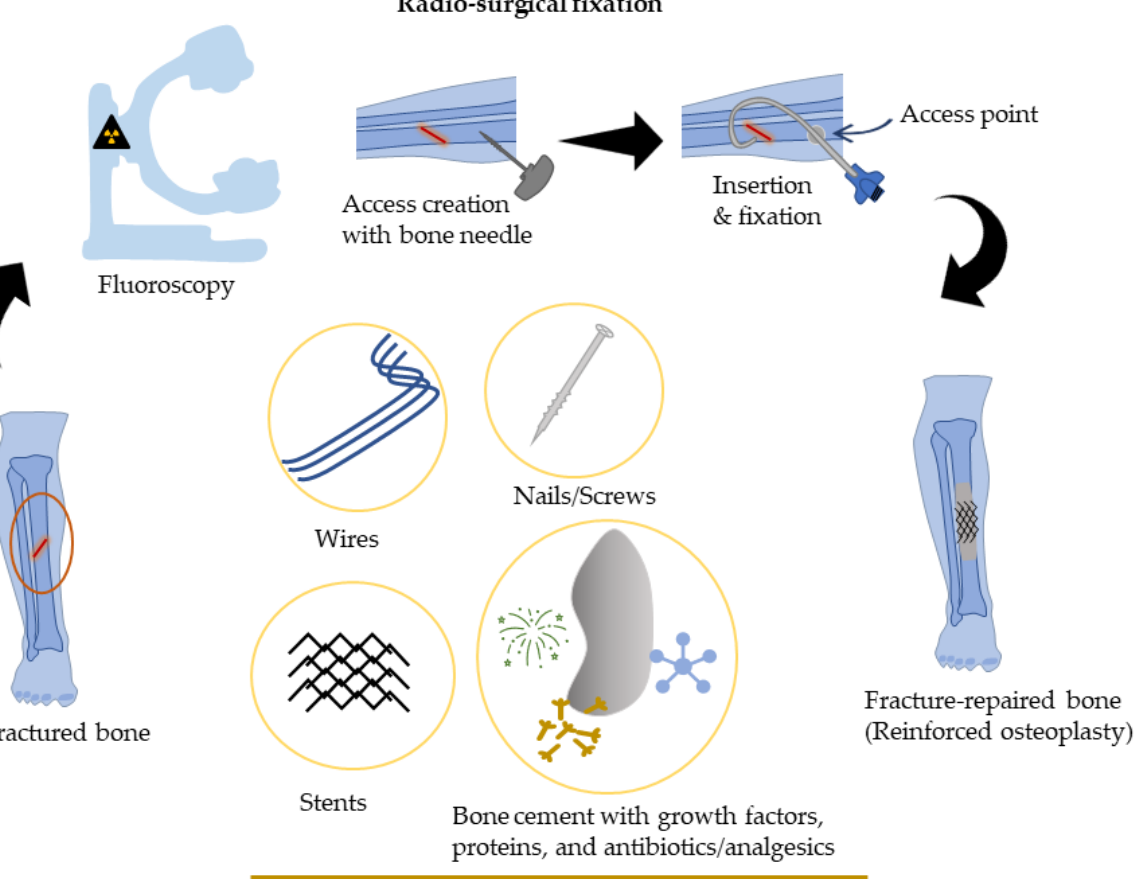
Figure 1. Block diagram illustrating percutaneous-reinforced osteoplasty procedure. A mid-diaphyseal fracture of the tibia in a strictly “non-surgical” patient is repaired radio-surgically by creating access with a bone biopsy needle followed by insertion of reinforcement material(s) and cement augmentation.